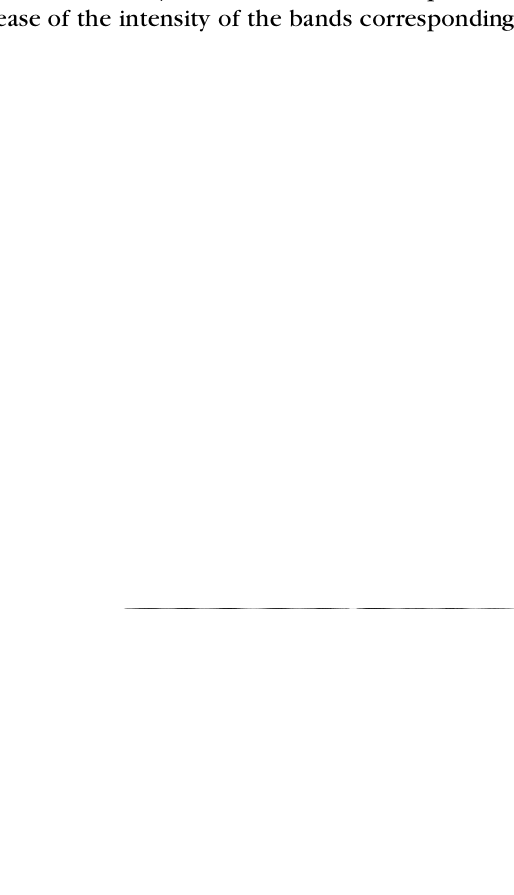
FIG. 5. Effect of DPI on IL-1-induced ROS production. The fluorescence intensity of chondrocyte cultures preloaded with DCFH 2 -DA was measured after treatment with IL-1 (20ng/ml), in the presence or absence of the indicated concentrations of DPI, as described in Materials and meth- ods. Results are expressed as the percent increase of the fluorescence intensity relatively to control cells, which were loaded with DCFH 2 -DA but otherwise left untreated. Each bar represents the mean ± SD of three independent experiments, each performed in triplicate.* p < 0.05 relative to